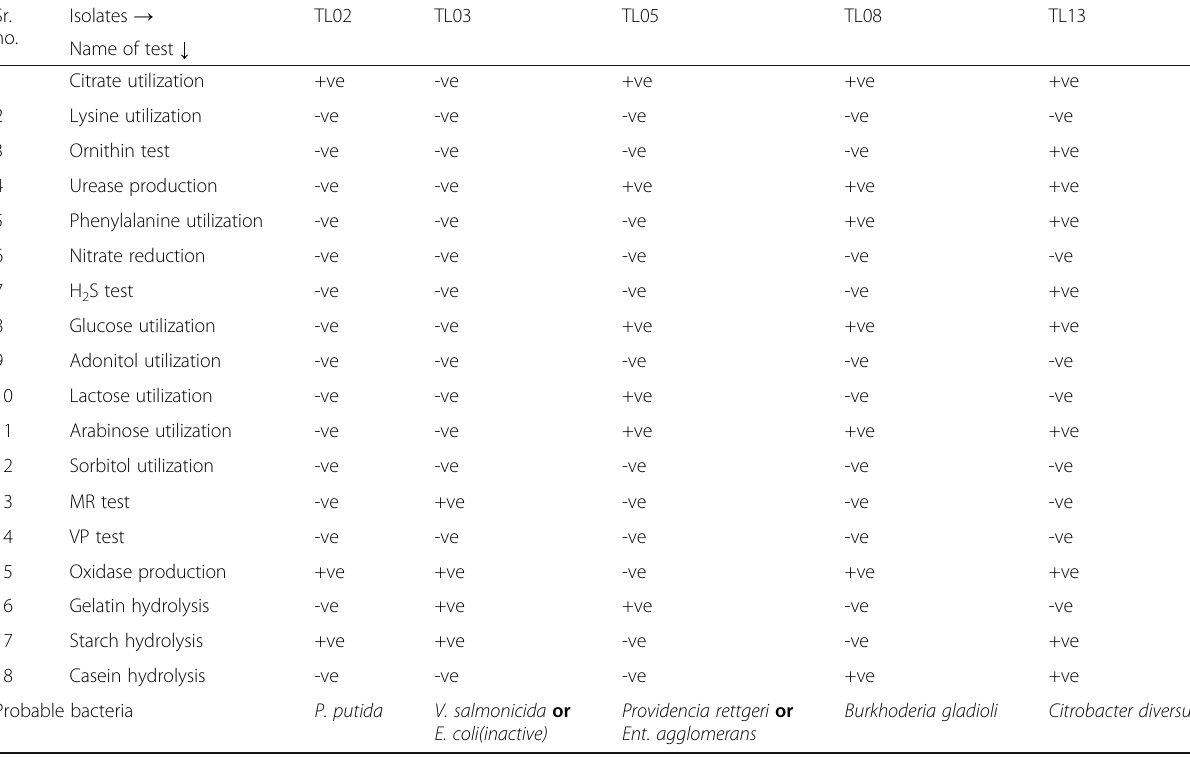
Table 7 Biochemical characterization of Gram-negative isolates from used leech Sr.